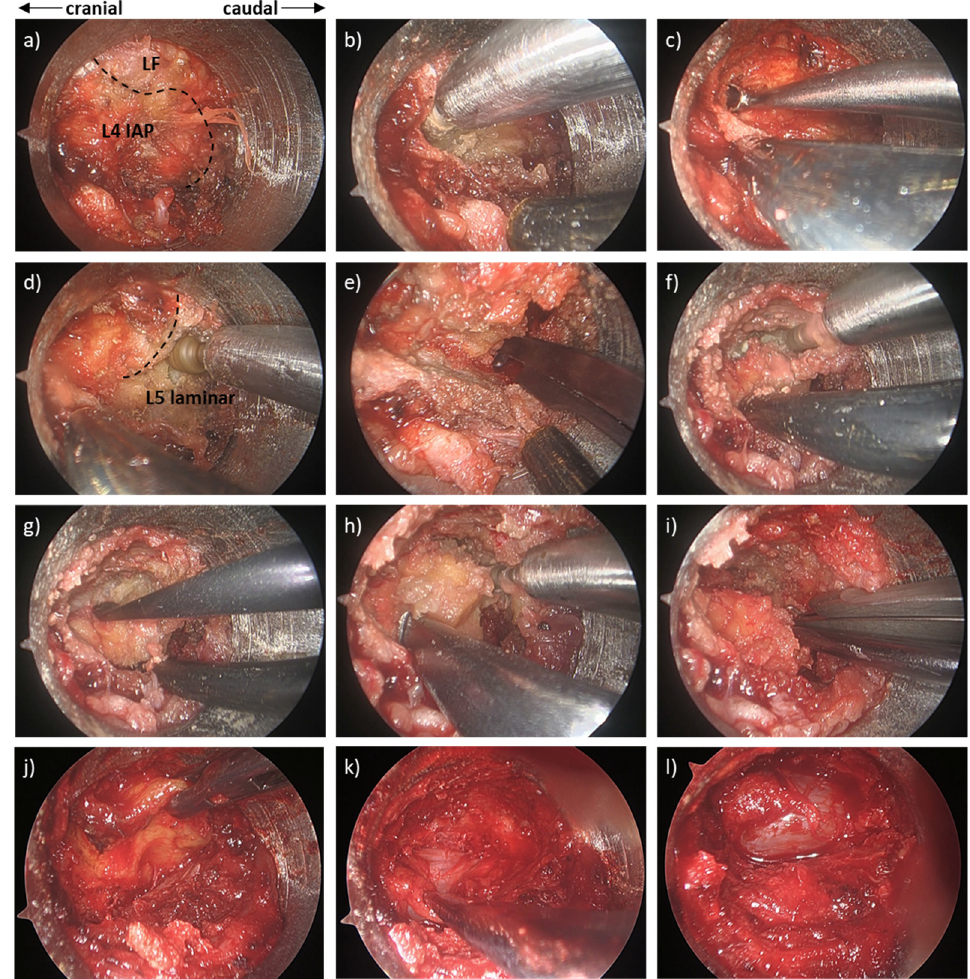
Figure 4. Intraoperative microendoscopic photograph during microendoscopic decompression for L4/5 lumbar spinal stenosis using a paramedian approach. ( a ) Before laminotomy (LF; ligamentum flavum, IAP; inferior articular process). ( b ) Drilling of the caudal side of the L4 lamina and medial part of the L4 IAP. ( c ) Detachment of the LF from the L4 lamina using a curved curette. ( d ) Drilling of the cranial side of the L5 lamina. ( e ) Resection of the medial side of the L5 superior articular process (SAP) using Kerrison rongeurs. ( f ) Drilling of the base of the L4 spinous process and contralateral L4 lamina and IAP. ( g ) Detachment of the LF from the contralateral L4 IAP using a dissector. ( h ) Drilling of the base of the L5 spinous process and contralateral L5 lamina and SAP. ( i ) Resection of the contralateral medial side of the L5 SAP using Kerrison rongeurs. ( j ) Removal of the LF. ( k ) Additional resection of the remaining LF and medial facet with confirmation of adequate decompression of the contralateral side. ( l ) Complete decompression after additional resection of the ipsilateral remaining LF and medial